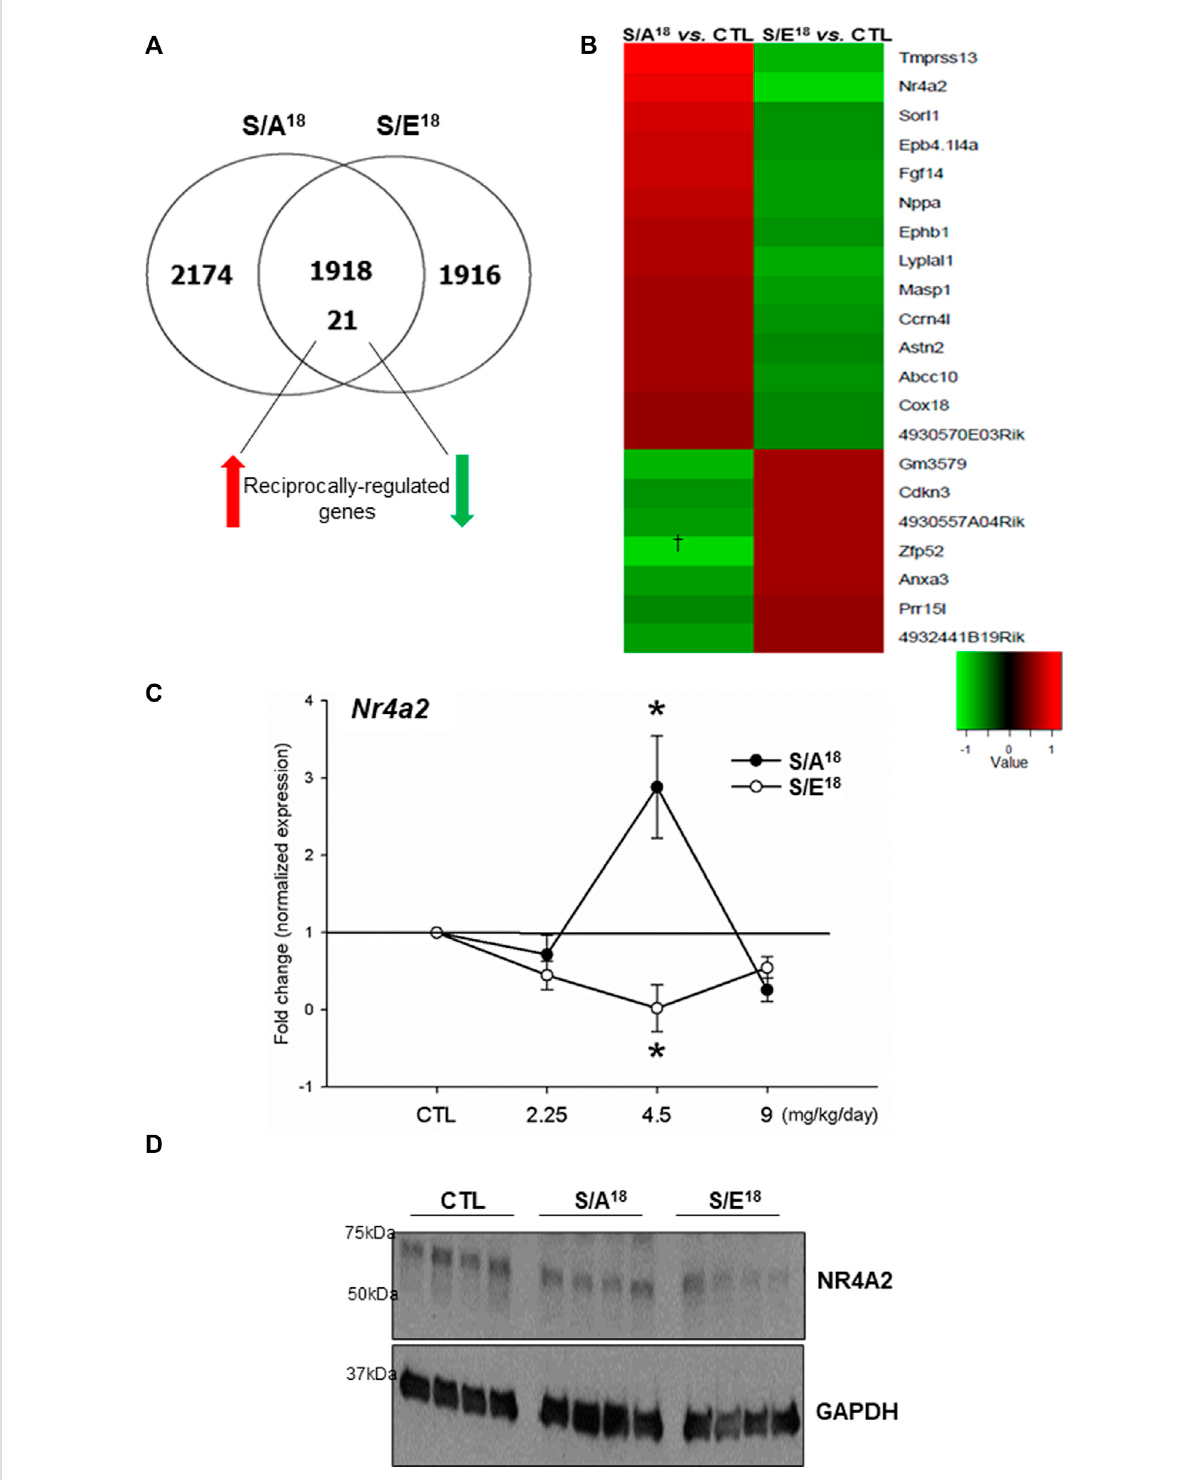
FIGURE 4 Microarrayanalysisofgeneexpressionintheheartsofpeptidetreatedmiceat4.5 mg/kg/daydose. (A) .Venn-diagramshowingthesegregation of differentially expressed genes relative to control. (B) . Heat map of the 21 reciprocally regulated genes (Red = up-regulated, Green = down regulated). (C) . Nr4a2 mRNA expression in the heart at different doses ( *p < 0.05 vs. CTL n = 5). (D) . Immunoblots of NR4A2 protein expression abundance in the heart at 4.5 mg/kg/day